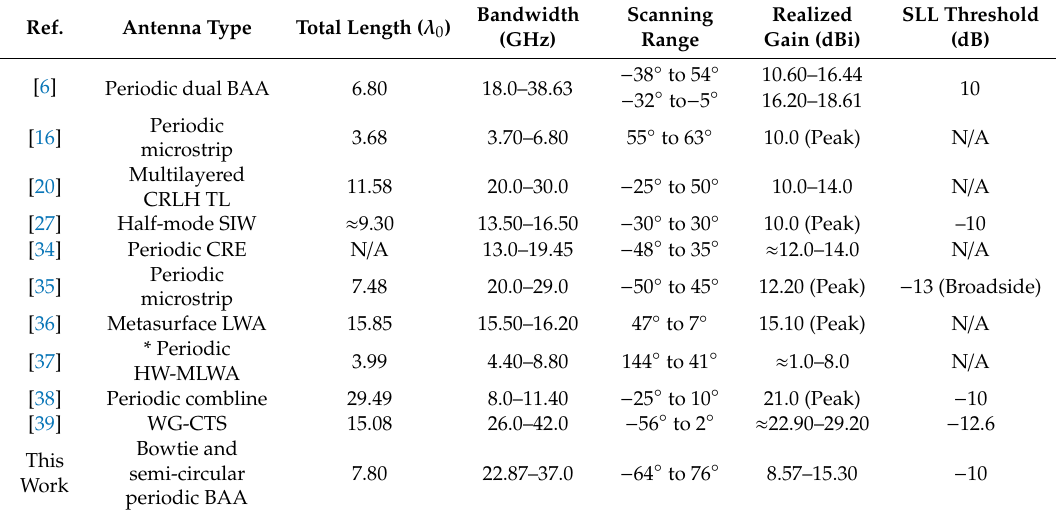
Table 2. Table of performance comparison between proposed LWA and LWAs in